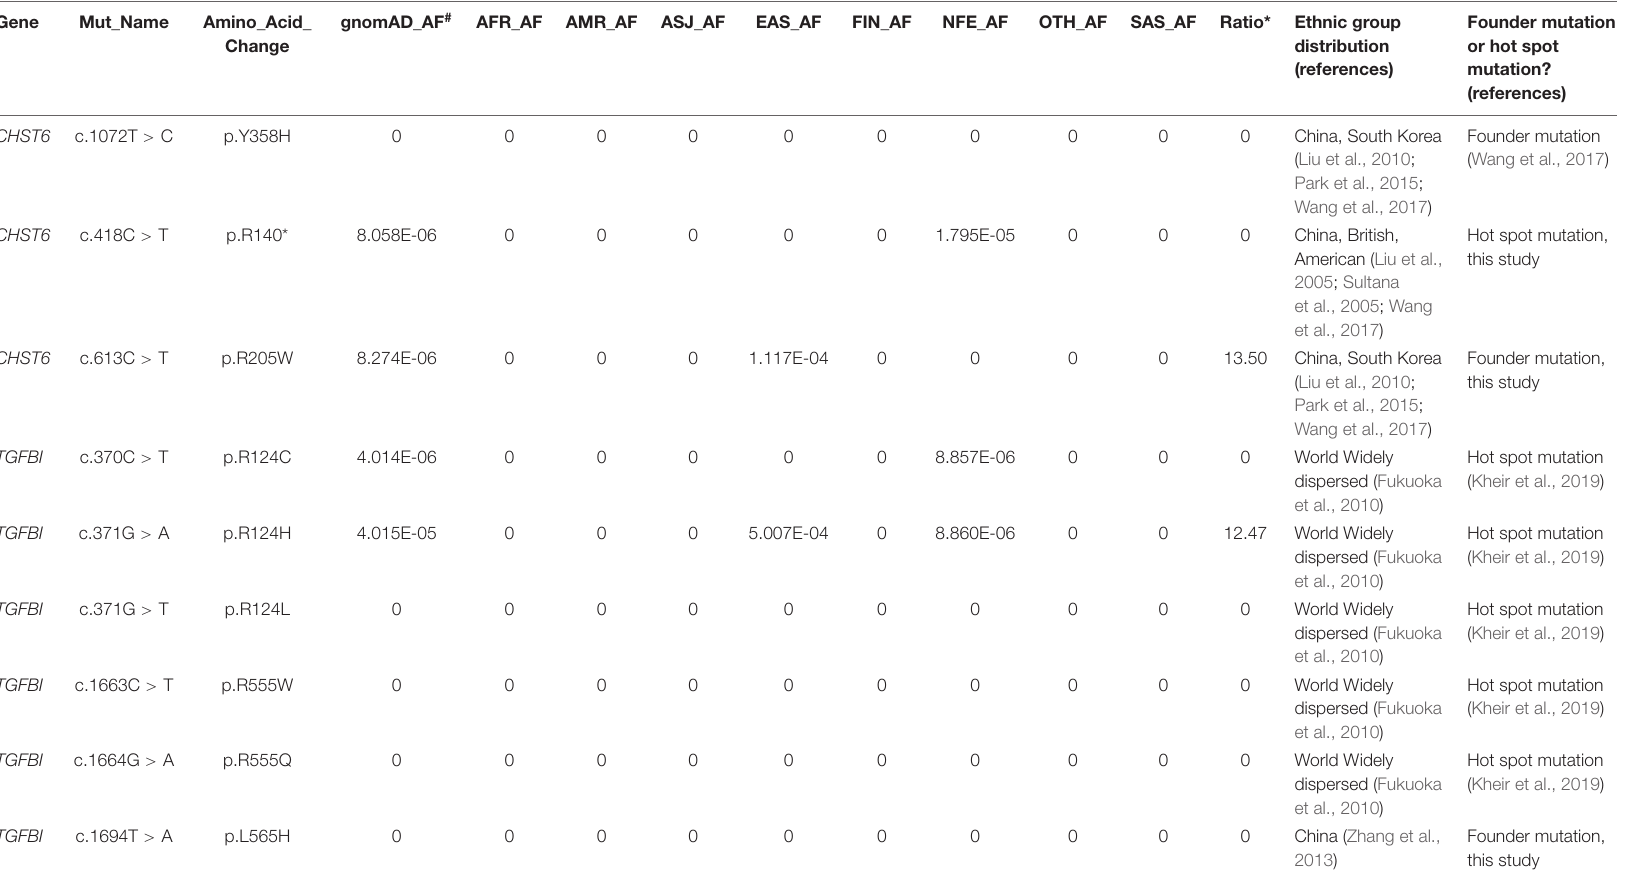
The allele frequencies in the respective ethnic group was determined from gnomAD database (v.2.1.0). # gnomAD_AFR_AF: African/African American; gnomAD_AMR_AF: American Admixed/Latino; gnomAD_ASJ_AF: Ashkenazi Jewish; gnomAD_EAS_AF: East Asian; gnomAD_FIN_AF: Finnish;